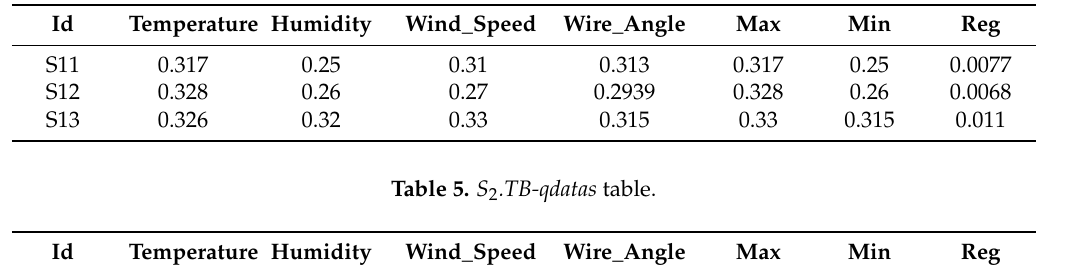
Table 4. S 1 . TB-qdatas table.